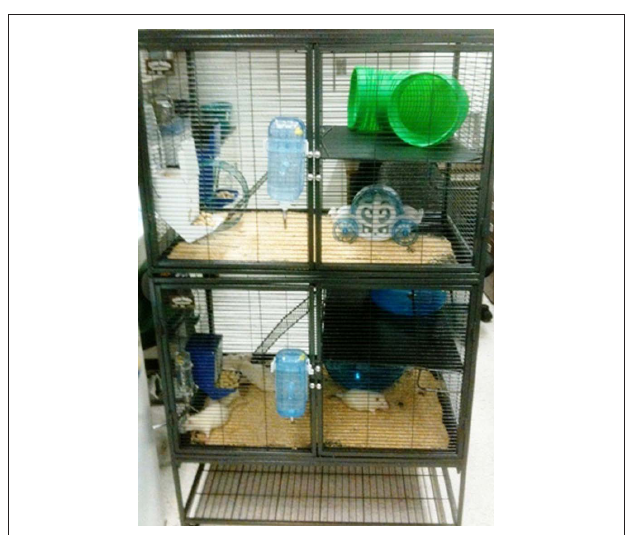
Figure A1 | Photograph of enriched environment housing